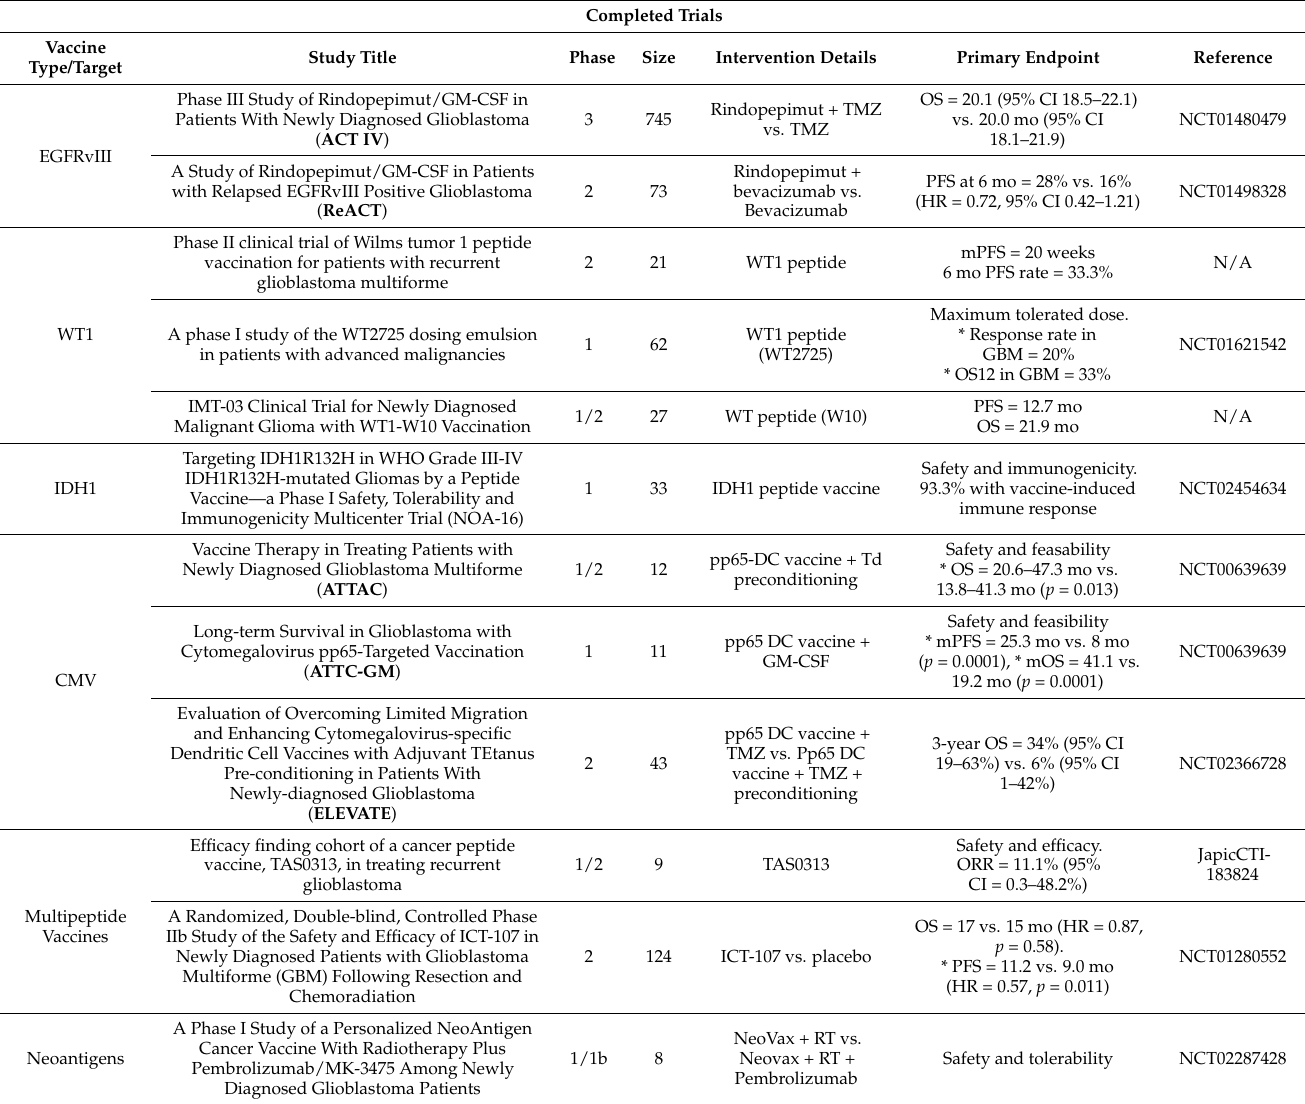
Table 1. Completed and ongoing peptide vaccine clinical trials for